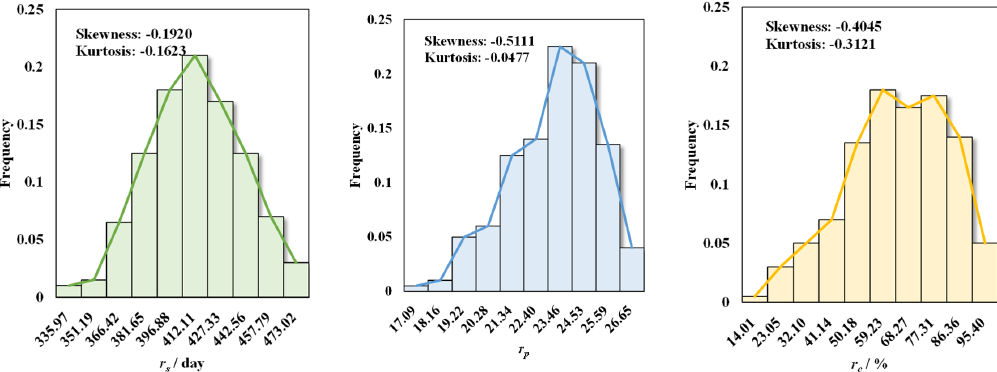
Figure 5. Frequency distributions of r s , r p , and r c .